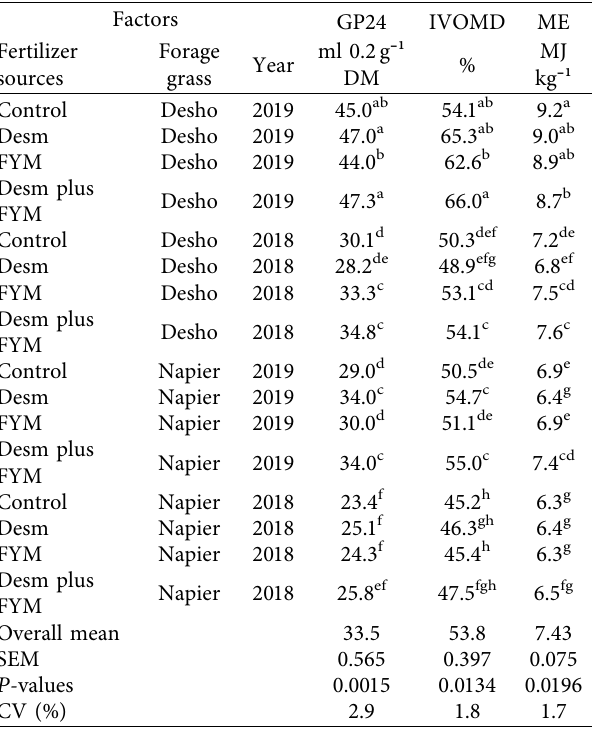
Table 4: Results of Tukey’s tests exploring the interaction effects of forage grasses, fertilizer treatments, and year on GP24, IVOMD, and ME contents at the Guder